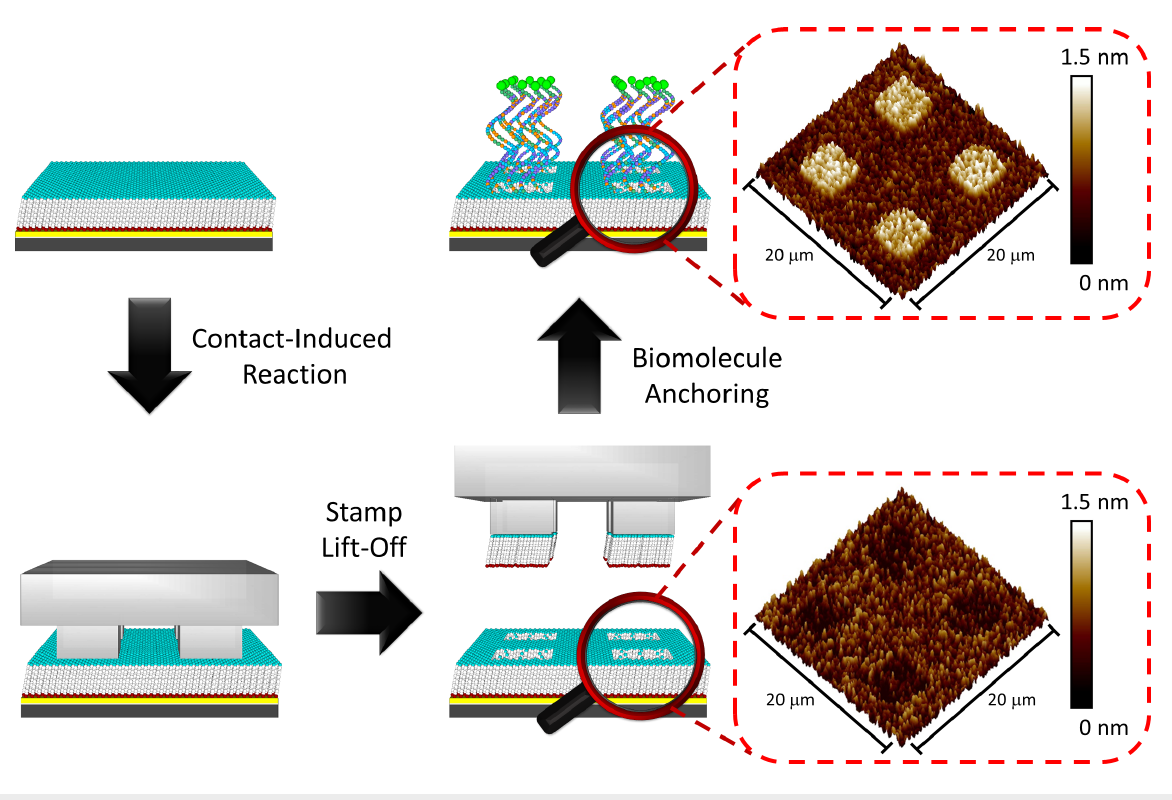
Figure 1: Schematic illustration and corresponding topographic AFM images of biological-probe-patterned surface fabrication using the chemical lift-off lithography (CLL) process.